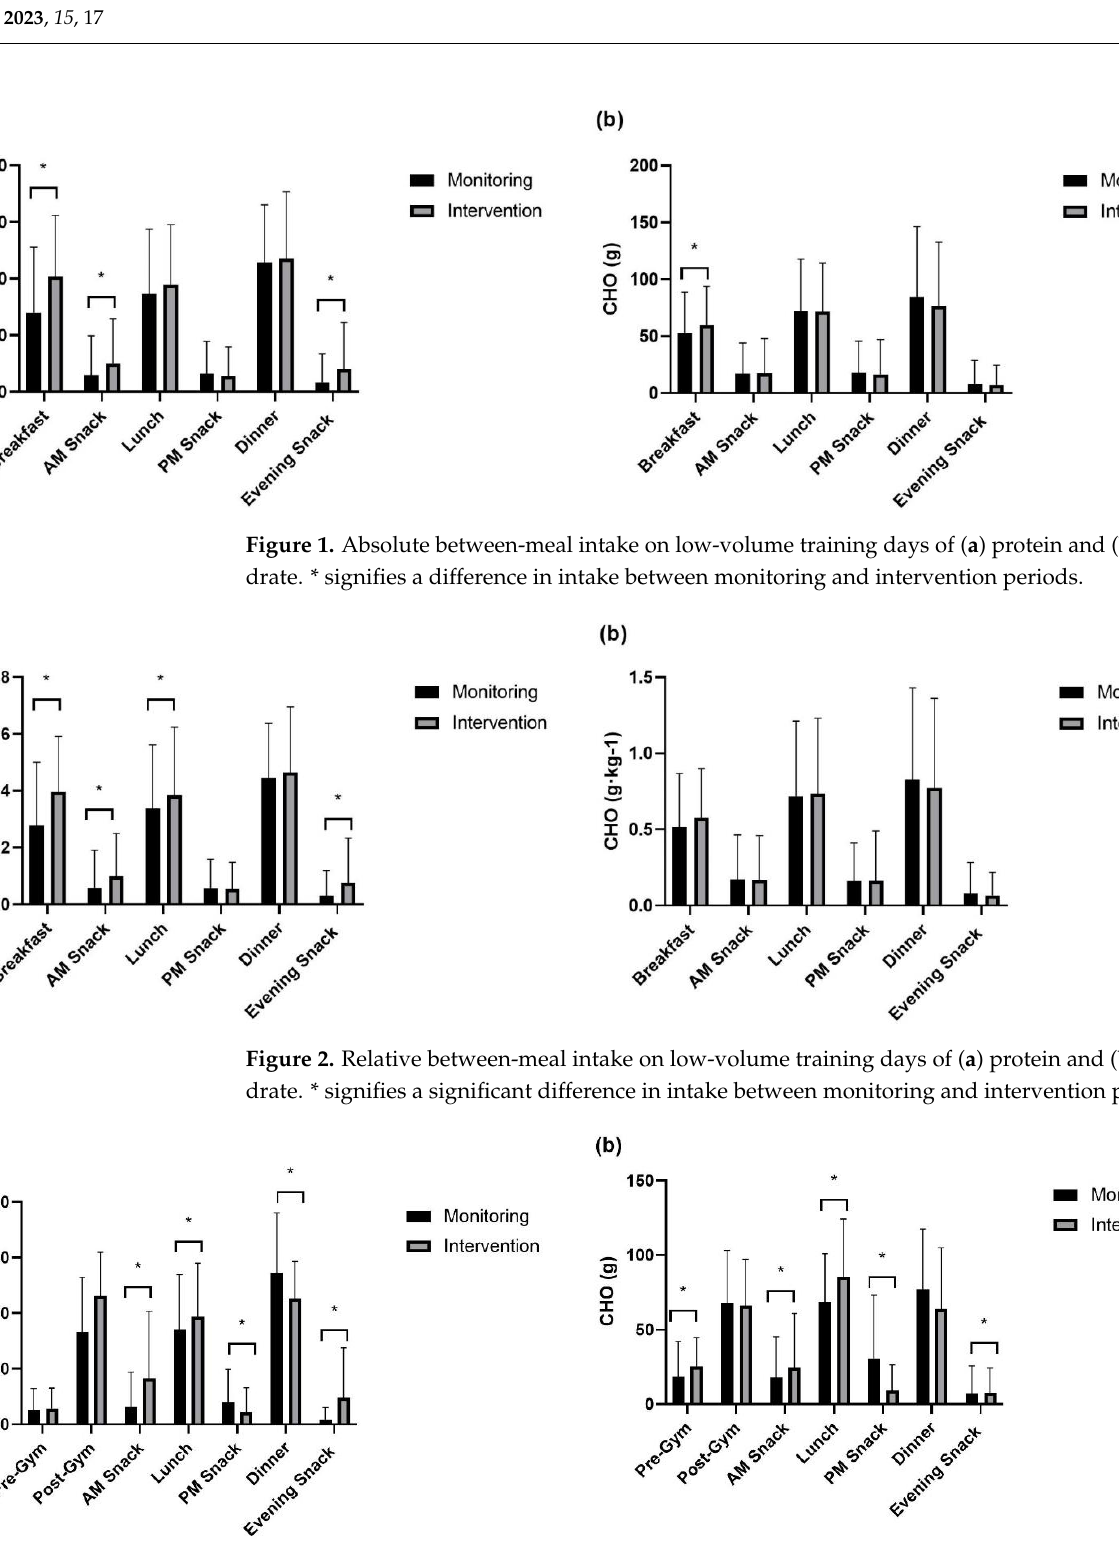
Figure 4. Relative between-meal intake on high-volume training days of ( a ) protein and ( b ) carbo- hydrate. * signifies a significant difference in intake between monitoring and intervention periods. 4. Discussion The purpose of this study was to examine the impact of full-time holistic support provided by a sports nutritionist to athletes in a provincial, sub-elite rugby union academy in New Zealand on the within-day distribution of protein and carbohydrates and subse- quent changes to lean body mass. The implementation of full-time support may have fa- cilitated a more balanced intake of dietary protein towards a recommended 0.4 g ‧ kg −1 per meal without a corresponding change in lean body mass [14,15]. Absolute carbohydrate intake was greater at breakfast on low-volume training days and differed at multiple eat- ing occasions on high-volume training days. Dietary protein intake was greater at multiple eating occasions on both low-volume and high-volume training days. The likely major influence on dietary protein intake was the incorporation of behaviour- change techniques into the intervention. Specifically, ‘add- ing objects to the environmen t’ in the form of supplemental dietary protein likely encour- aged greater consumption at multiple eating occasions. Dietary protein intake signifi- cantly increased at the breakfast eating occasion on low-volume training days and the post-gym eating occasion on high-volume days (usually corresponding with breakfast due to the timing of morning training) towards the proposed 0 ‧ 4 g ‧ kg −1 per meal threshold [14,15]. The distribution of adequately dosed protein throughout the day has been